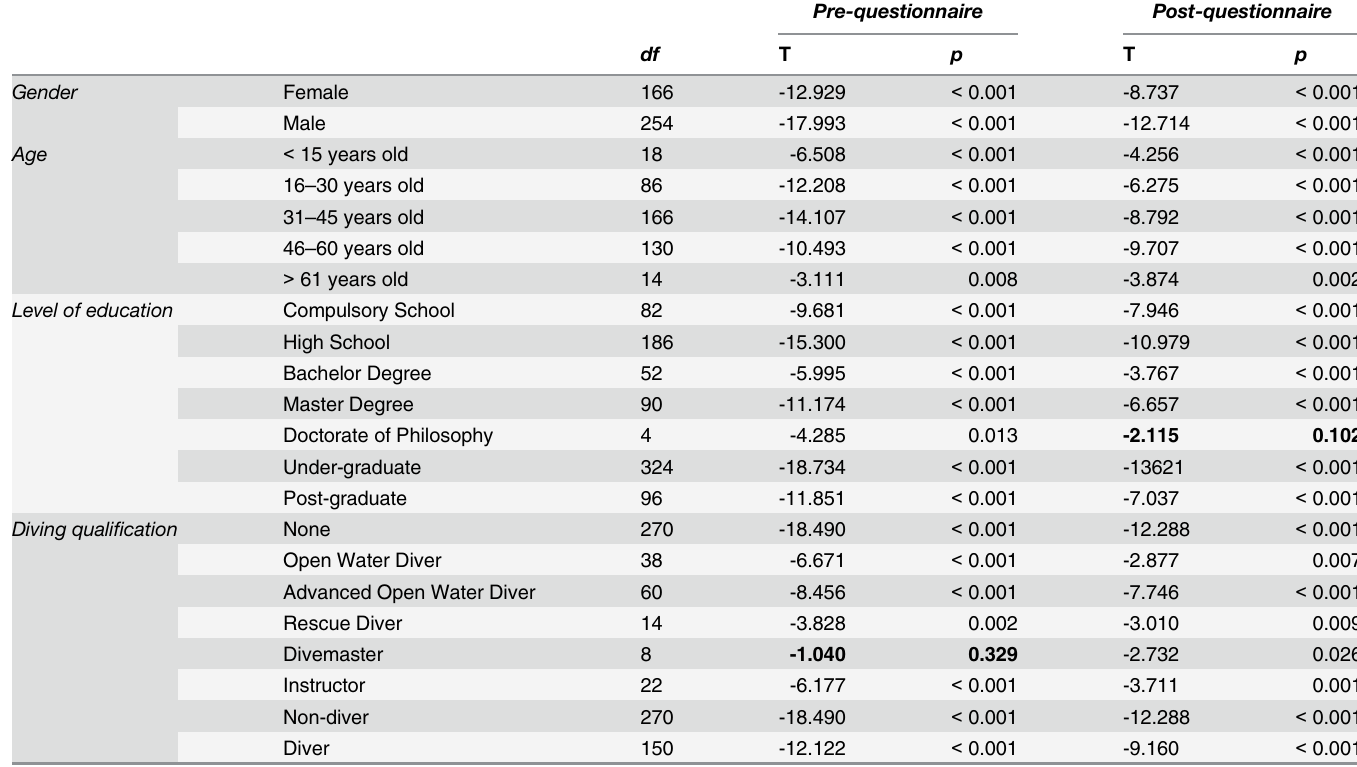
Table 4. Results of T student test between the mean score of the reef biology and the human impact questions, in the pre- and in the post- questionnaire.